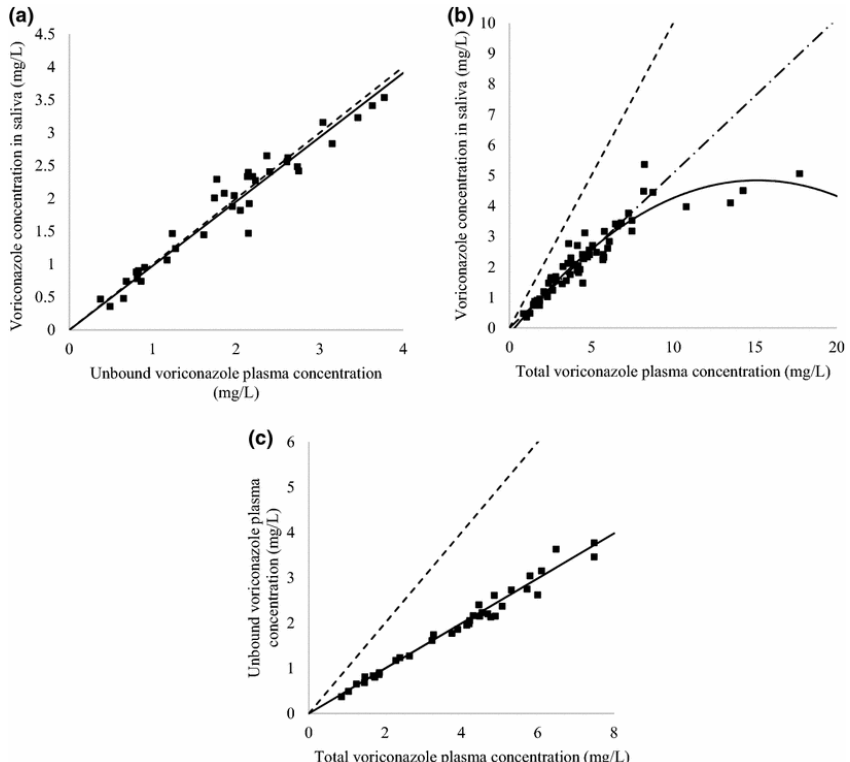
Figure 6. Scatterplots with linear mixed modeling to assess the agreement between voriconazole concentrations in saliva and unbound ( a ) and total ( b ) plasma voriconazole concentrations, and the agreement between unbound and total plasma voriconazole concentrations ( c) . The identity lines are presented as dashed lines, and the regression lines are depicted as solid lines. In panel ( b ), the dashed–dotted line represents the regression line when total plasma voriconazole concentrations above 10 mg/L are excluded [82].